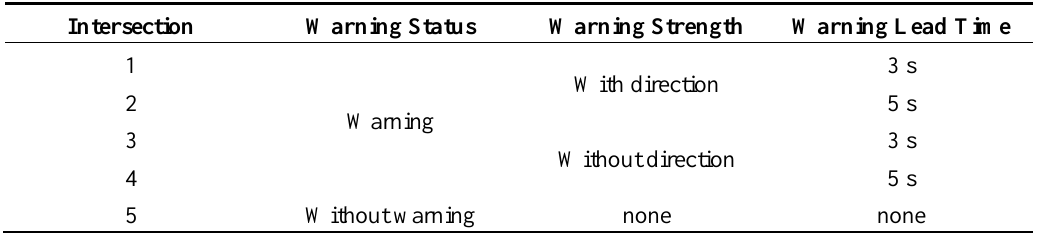
Table 2. Experimental scenarios based on different warning conditions.